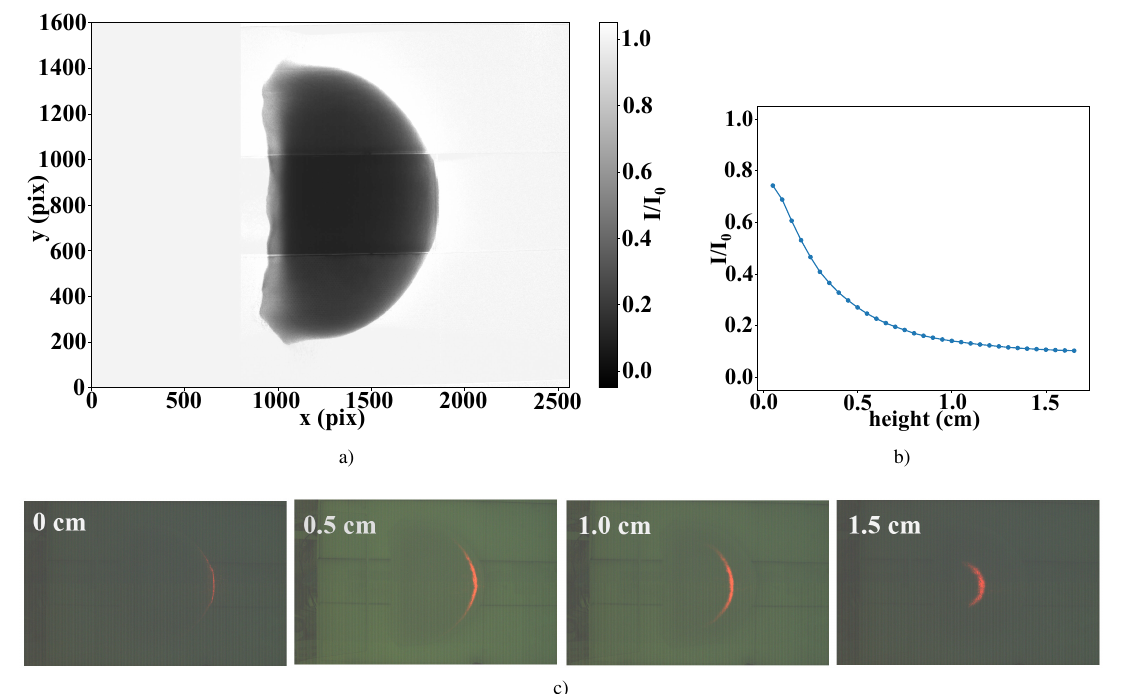
Figure 2. a) Normalized intensity image I / I 0 of a landslide. b) The resulting normalized intensity I / I 0 vs. height h calibration curve used to determine the height as a function of space h ( x ,y ). c) Images showing the laser sheet height positions used for the